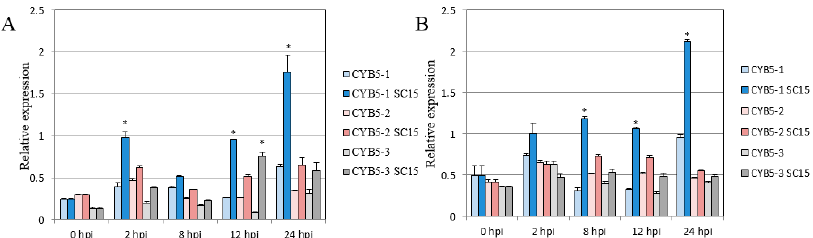
Figure 3. Analysis of mRNA levels of CYB5 isoforms in soybean. Relative mRNA levels of GmCYB5 isoforms in ( A ) susceptible plants (cv. NN1138-2) or ( B ) resistant plants (cv. RN-9) with or without SMV (SC15) infection. Samples are collected at 0, 2, 8, 12, and 24 h post infection (hpi) and quantified by qRT-PCR. Error bars indicate SD ( n = 3). Asterisks denote the significant difference between pathogen-treated and control plants for each respective isoform, t-test, p < 0.001. Results are representative of two–three independent experiments.